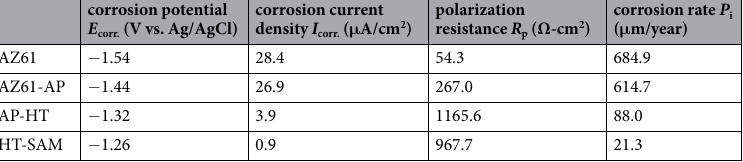
Table 2. Electrochemical parameters of the AZ61 Mg alloy, surface modified AZ61-AP, AP-HT, and HT-SAM specimens in R-SBF at 37